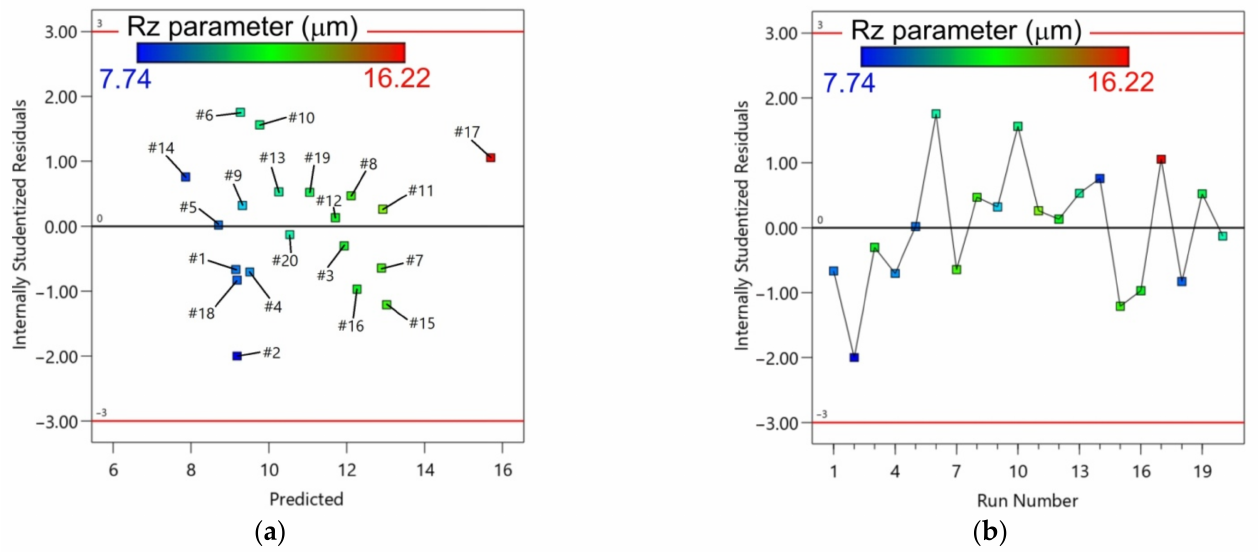
Figure 14. Residuals with reference to: ( a ) predicted; and ( b ) run number for the surface parameter